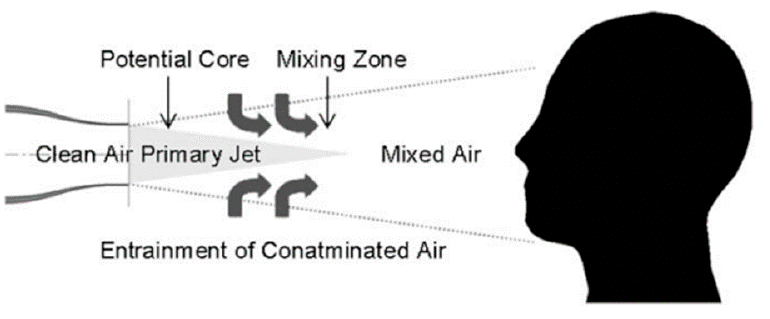
Figure 13. Airflow from a nozzle [144].